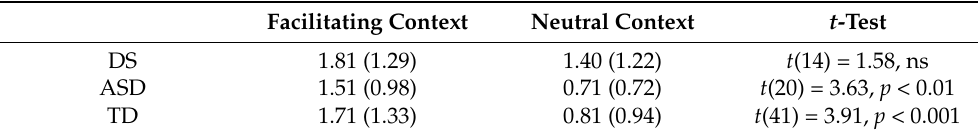
Table 3. Mean accuracy for homographs with less frequent pronunciation according to the context manipulation.